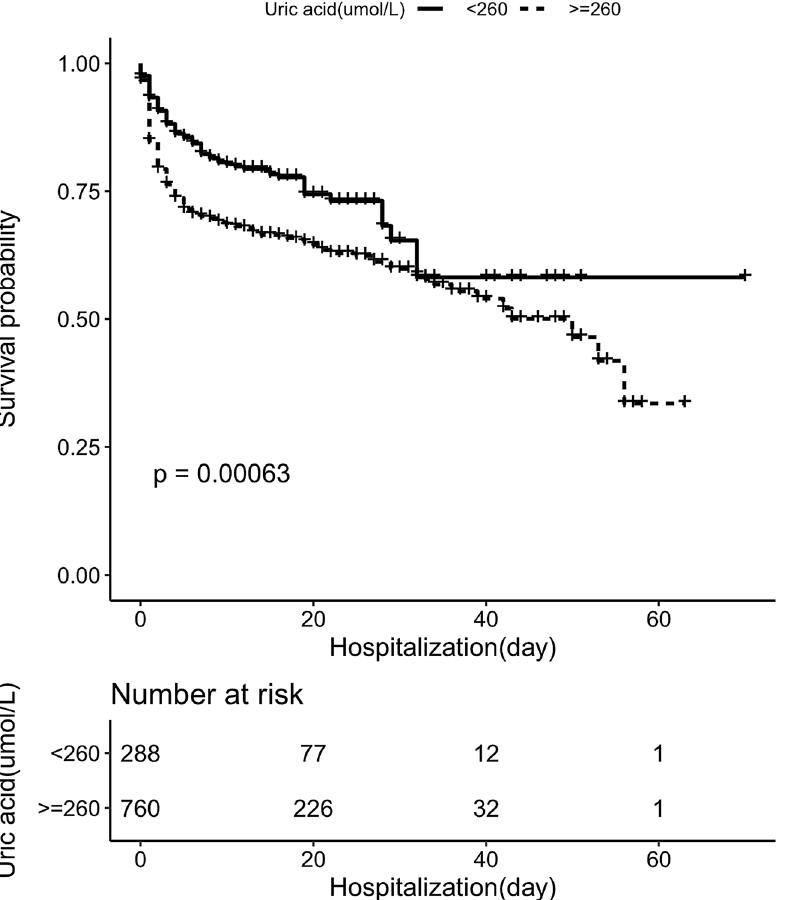
Figure 3. In-hospital survival curve analysis based on patients with